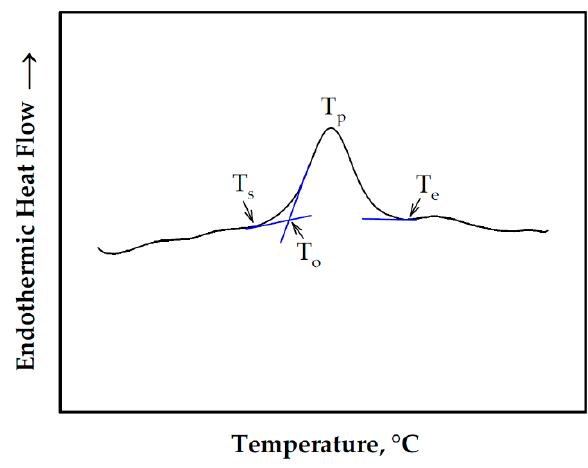
Figure 4. The endotherm characteristics from DSC curves: T s —start temperature; T e —end temperature; T o —onset temperature; T p —peak temperature.